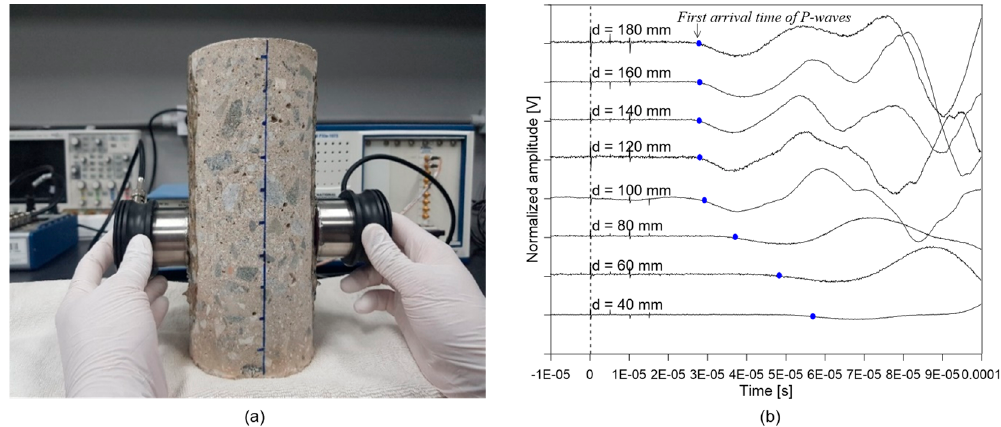
Figure 9. Test setup and typical signals from ultrasonic pulse velocity (UPV) measurements: ( a ) a picture of UPV measurements of a core sample with various depths and ( b ) typical time signals measured at the eight different depths (40, 60, 80, 100, 120, 140, 160 and 180 mm from the fire surface) by 50 kHz P-wave transducers.